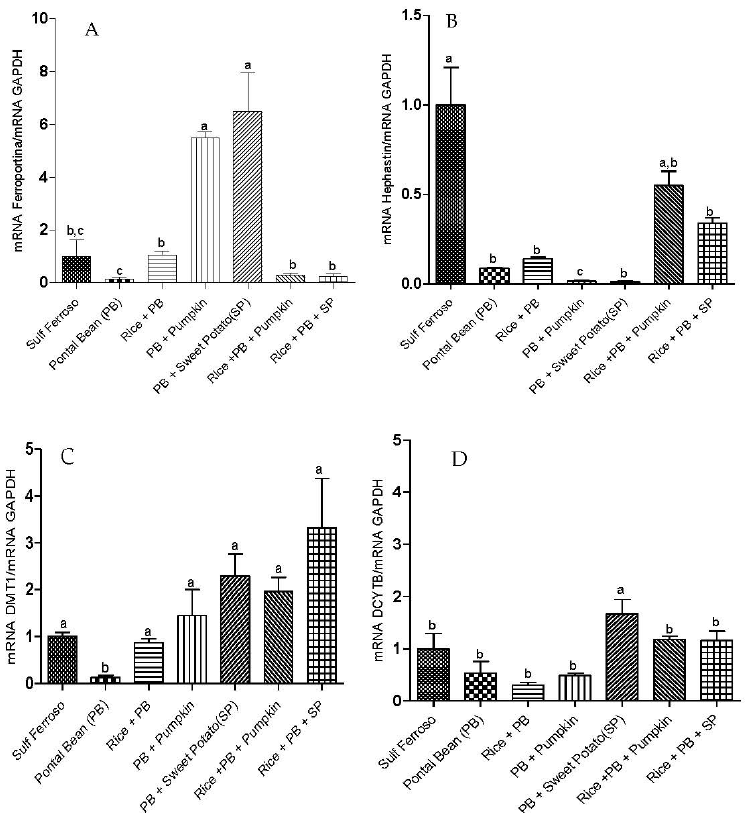
Figure 2. Effect of the ingestion of different combinations of staple food crops from micronutrients biofortification program and ferrous sulfate on the gene expression of proteins in duodenal tissue. RT-PCR Analysis. ( A ) Ferroportin; ( B ) Hephaestin; ( C ) DMT-1; ( D ) Dcytb. FS: Sulfate Ferrous; PB: Pontal Bean; PB + R: Pontal Bean + Rice; PB + P: Pontal Bean + Pumpkin; PB + SP: Pontal Bean + Sweet Potato; PB + R + P: Pontal Bean + Rice + Pumpkin; PB + R + SP: Pontal Bean + Rice + Sweet Potato. Different letters indicate statistical differences at 5% probability by Duncan test.